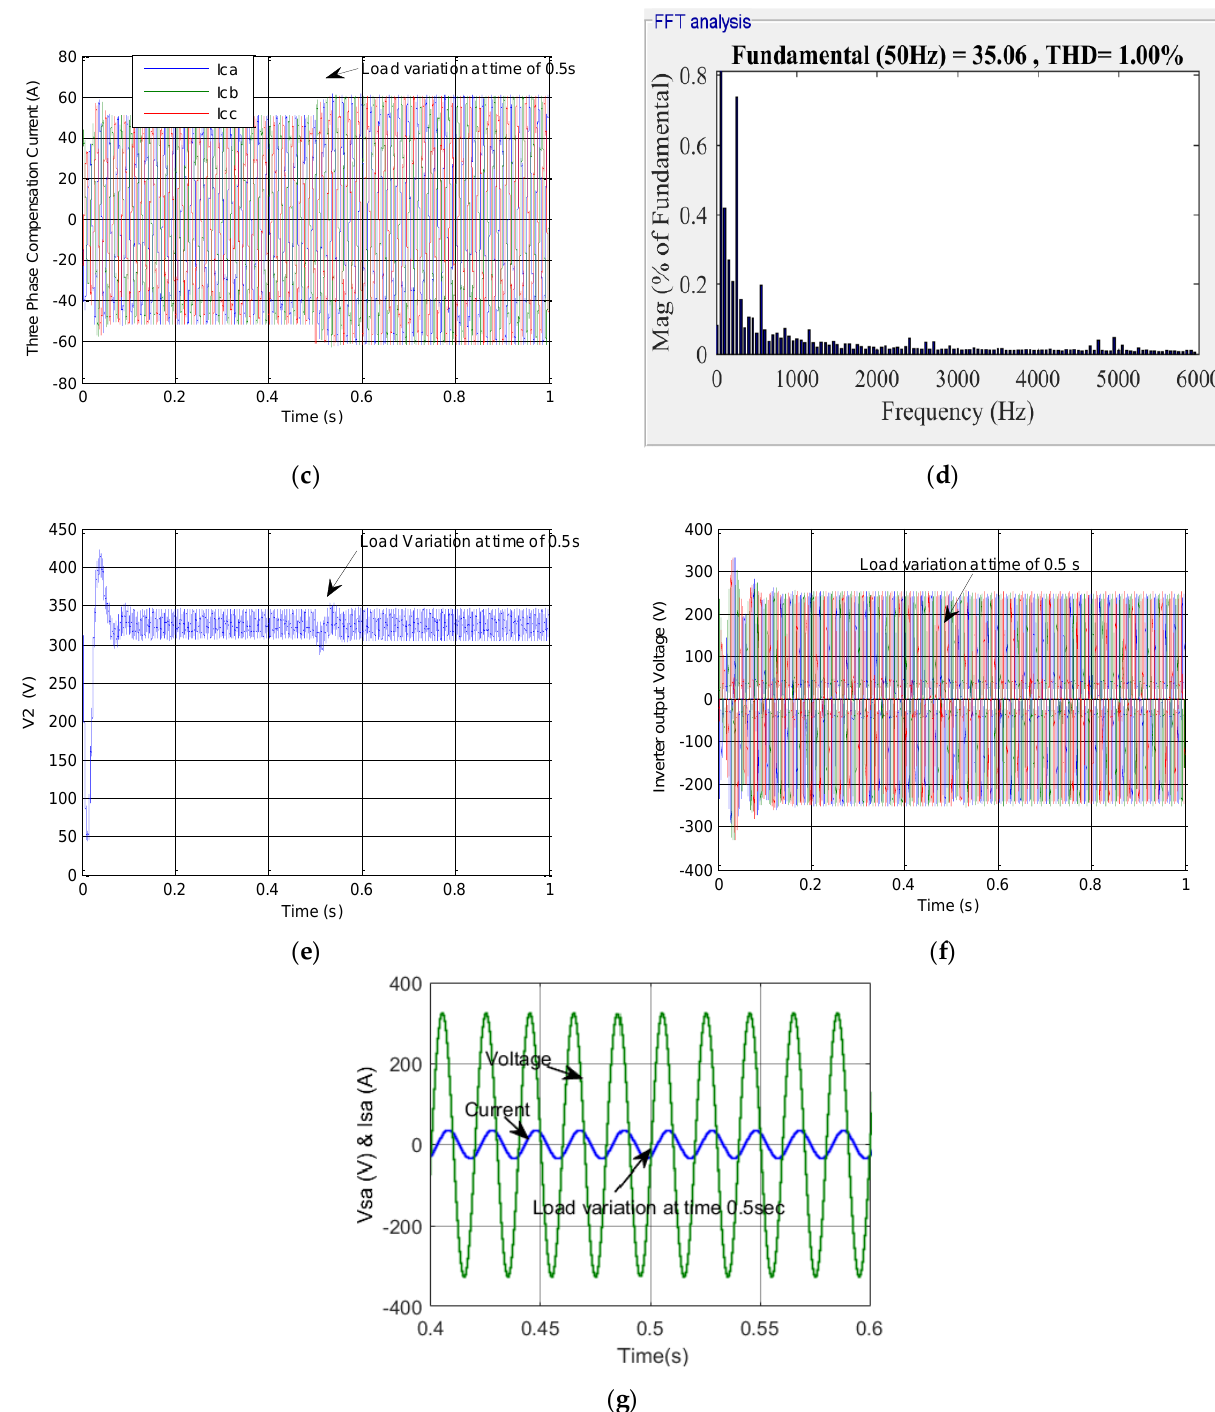
Figure 14. Simulated responses of three phase SSI-based SAPF connected at DRB RC load with SPWM and PI controller, ( a ) Supply current, ( b ) load current, ( c ) compensation current, ( d ) THD, ( e ) V 2 DC links voltage ( f ) SSI output voltage and ( g ) source voltage (V sa ) and source current (I sa ) of phase A.